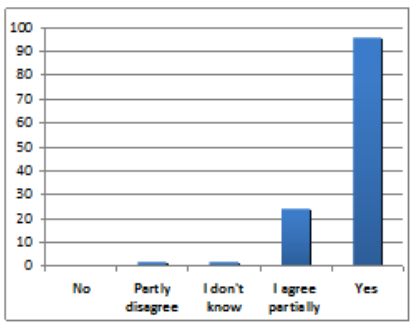
Figure 14. Graph showing the survey respondents answer to the question on whether integration of students and young researchers is important for developing an individual's